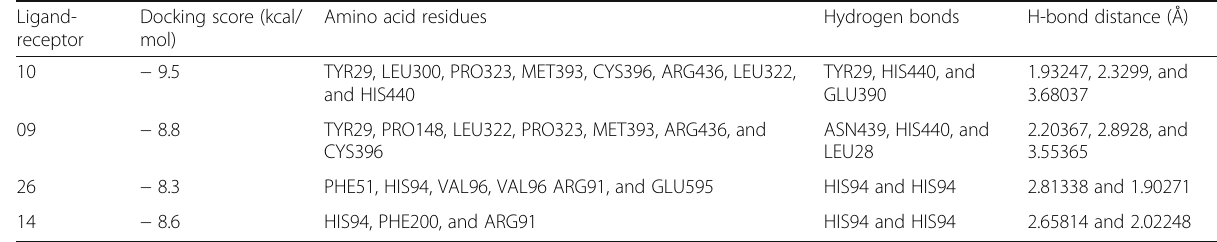
Table 6 The binding energy, amino acid residues, hydrogen bonds, and hydrogen bond distance of reported ligands Ligand- receptor